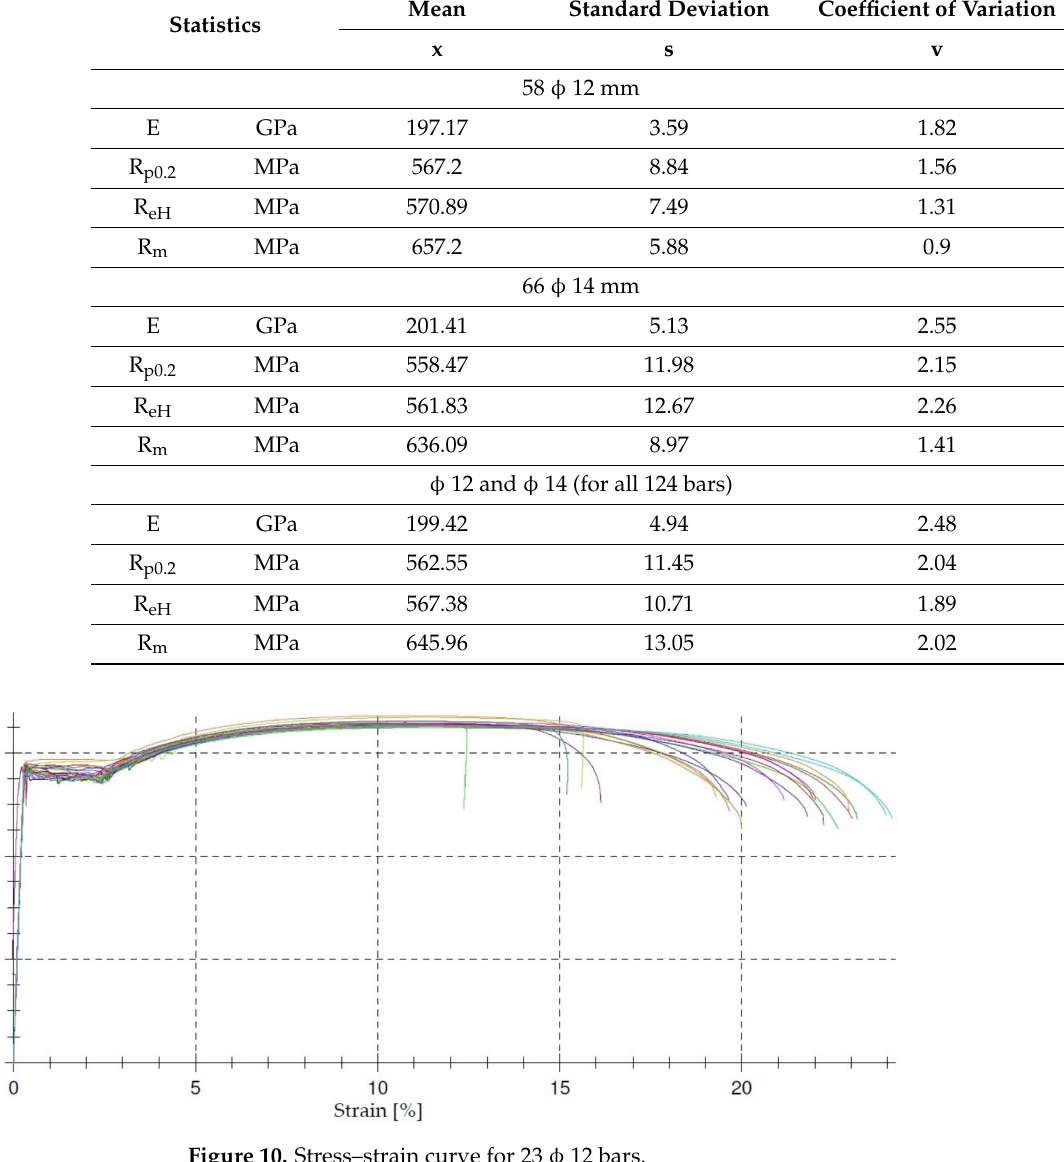
Table 6. Tensile test results for steel bars.